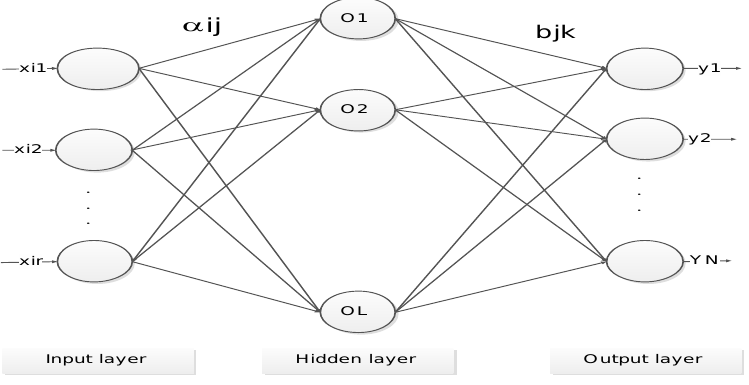
Figure 1. The structure of ELM.